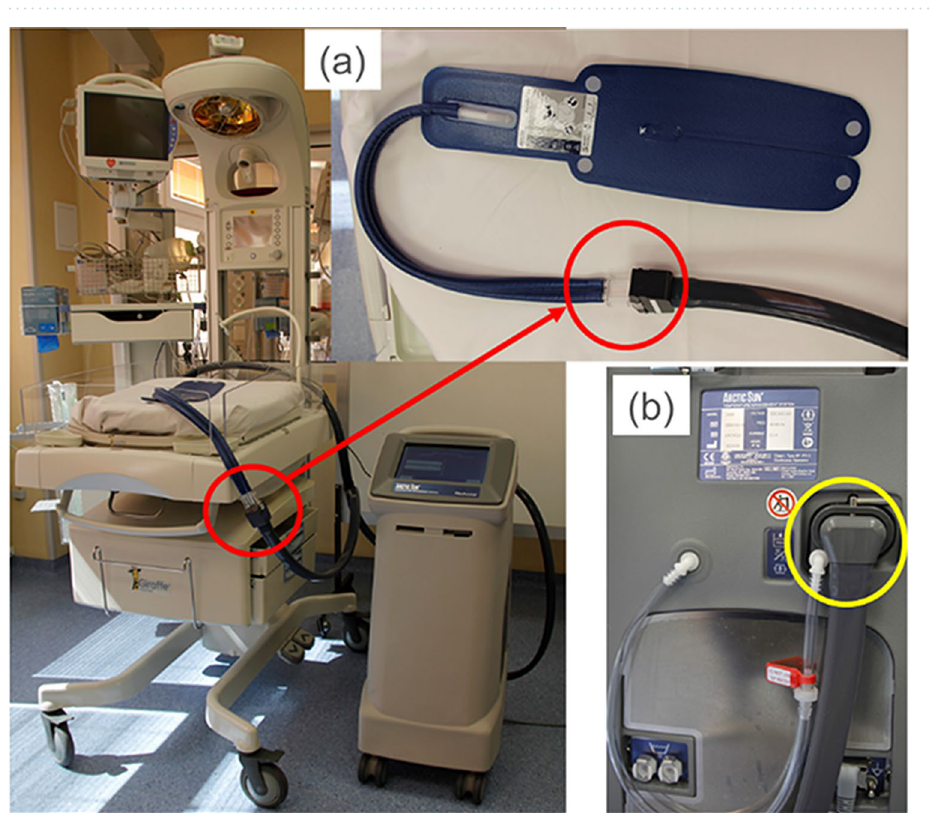
Figure 3. Whole body cooling device—( a ) the main tube with connections; ( b ) port on the back of control